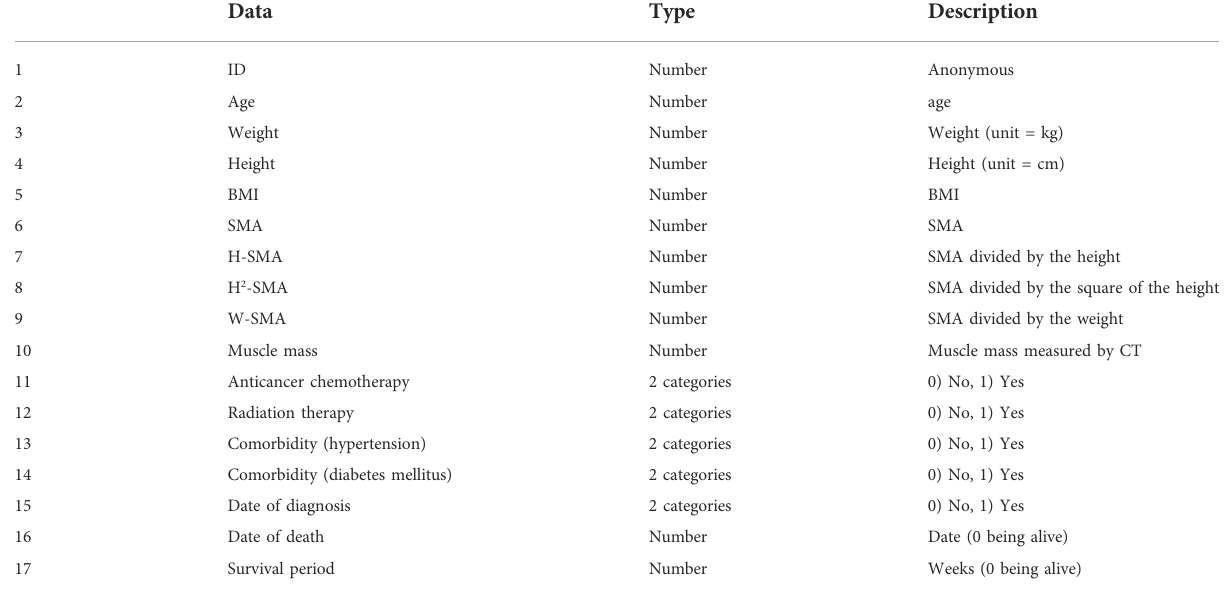
TABLE 1 Variables from patients ’